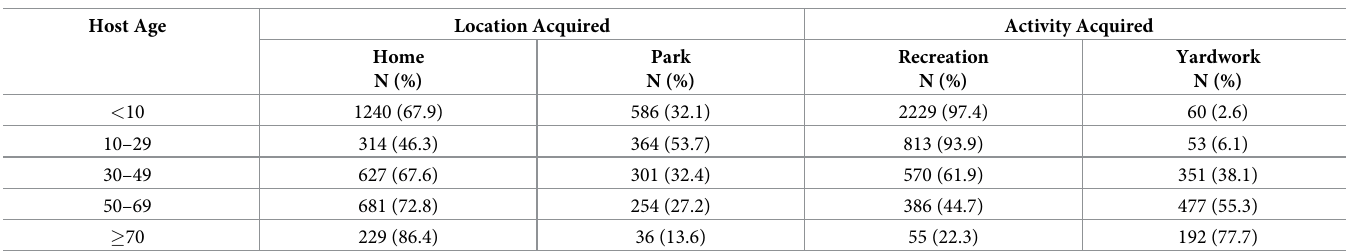
Table 5. Reported location and activity where ticks were